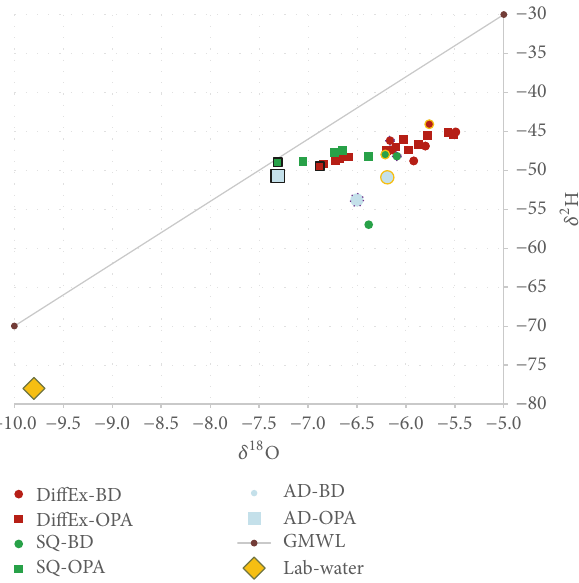
Figure 6: Water stable isotope composition of samples from advec- tive displacement, diffusive exchange, and pore water squeezing from samples of Opalinus Clay (OPA) and Brown Dogger (BD). Samples from similar depth as advective displacement samples are correlated by different borders around symbols (black, orange, and dotted). Errors on 𝛿 18 O are 0.15–0.2‰ and 1.5–2‰ for 𝛿 2 H, but precision is much better for samples measured in the same analytical sample series. DiffEx: diffusive exchange; SQ: squeezing; AD: advective displacement; GMWL: global meteoric water